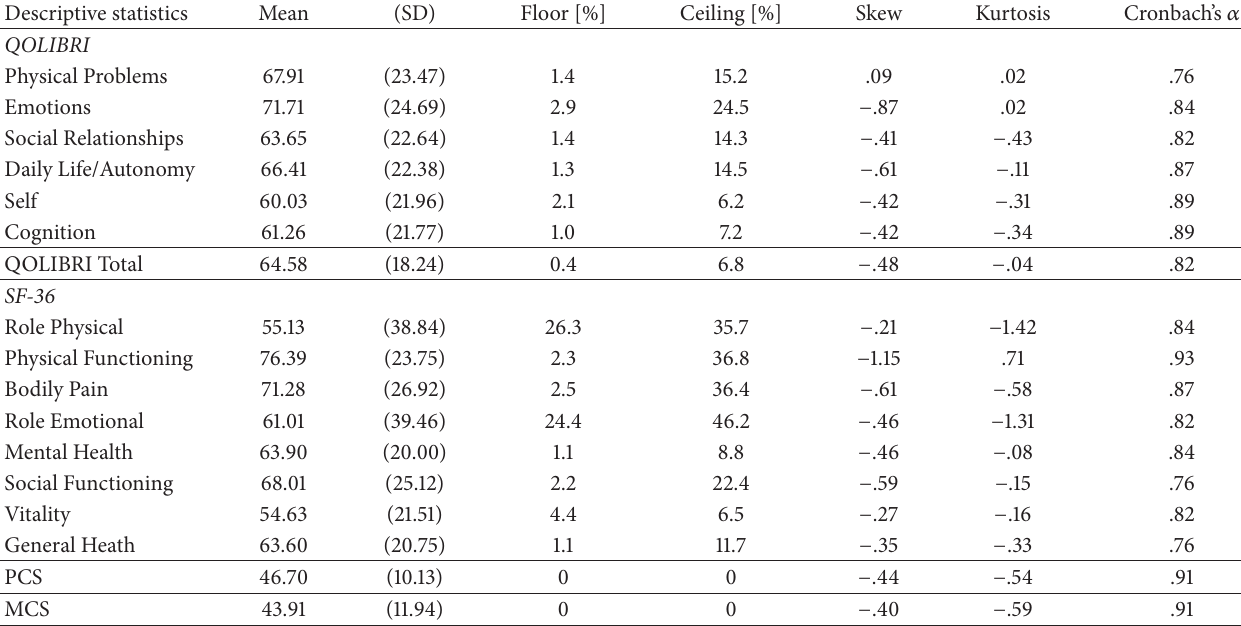
Table 2: Psychometric characteristics of the QOLIBRI and SF-36 subscales and summary